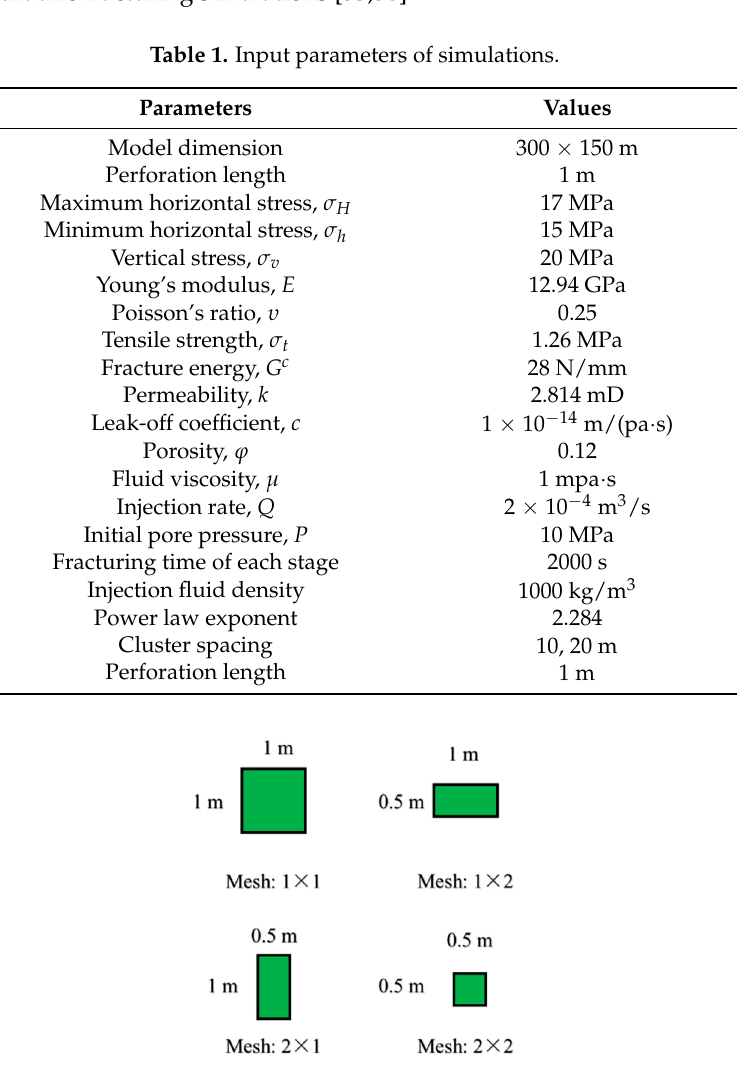
Table 1. Input parameters of simulations.